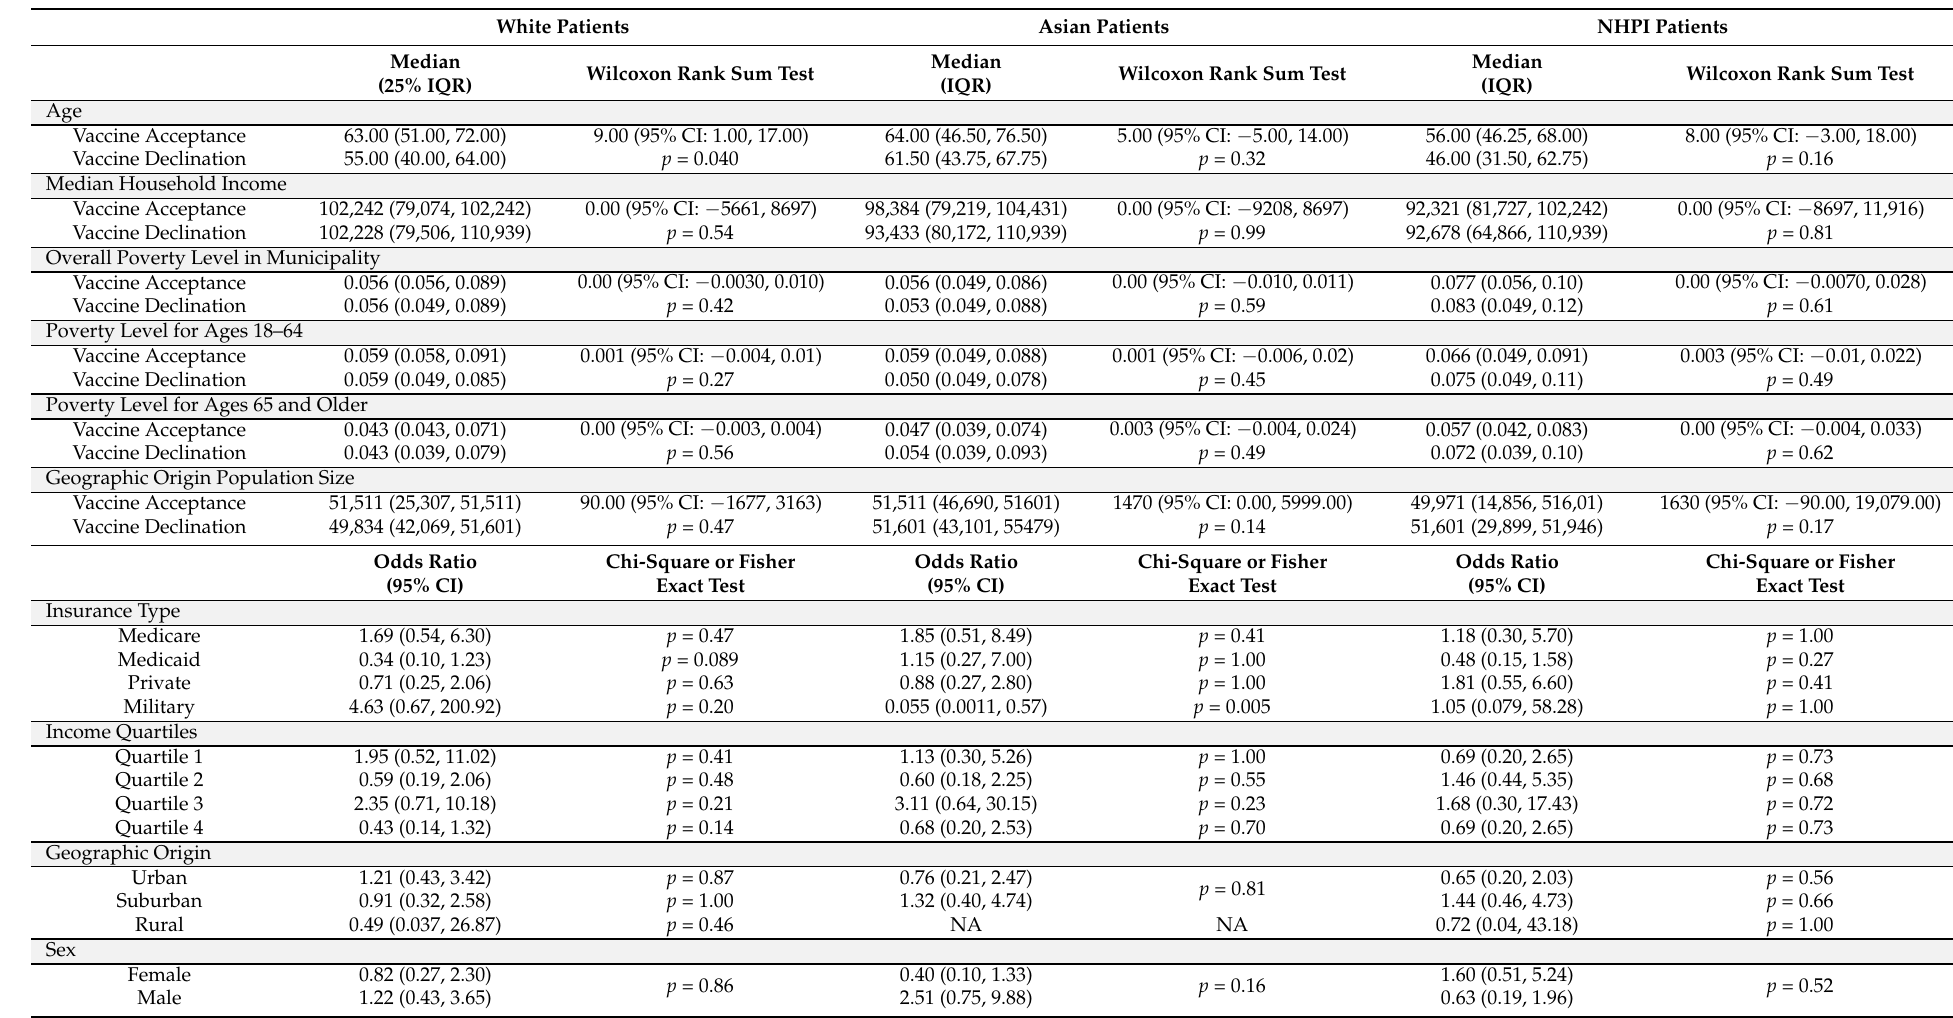
Table 5. Sociodemographic variables stratified by race: crude odds ratios. White